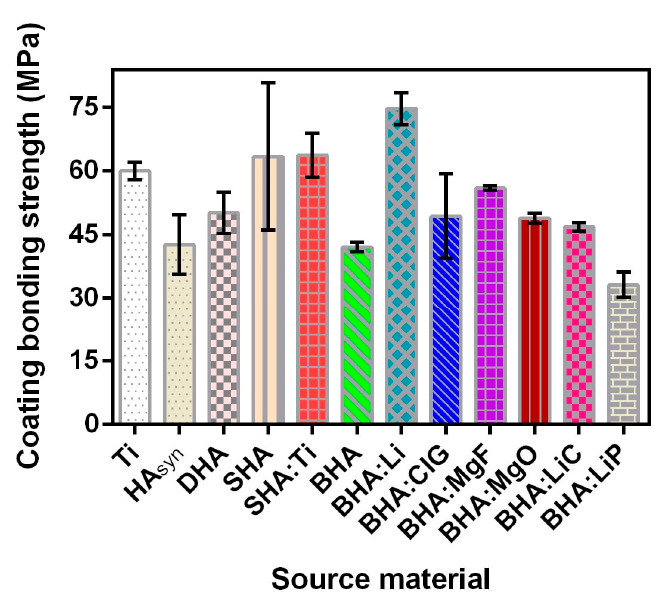
Figure 6. Bonding strength values in the case of titanium and different BioHA coatings synthesized by PLD using the same experimental conditions.